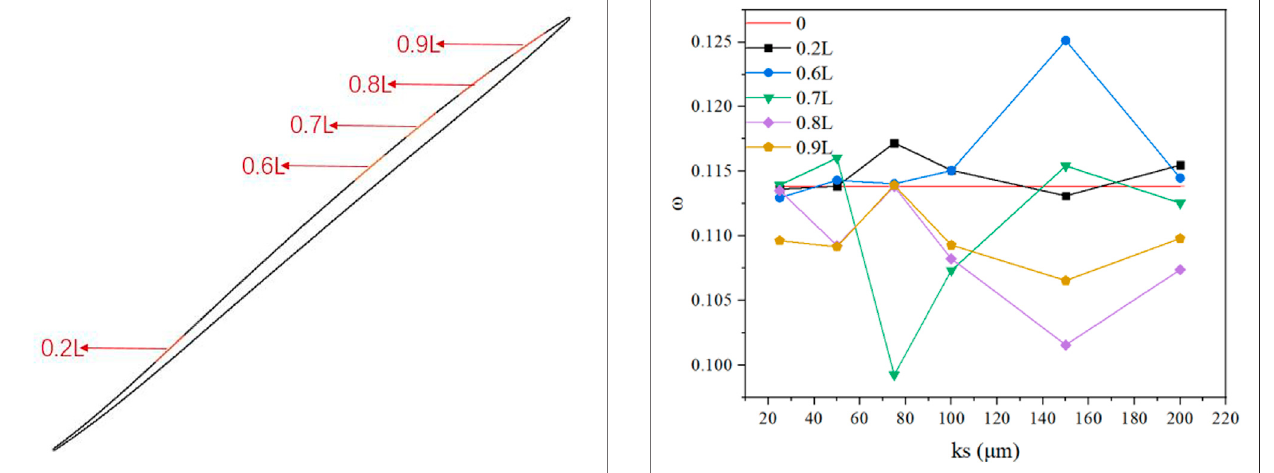
FIGURE 8 | Variation of total pressure